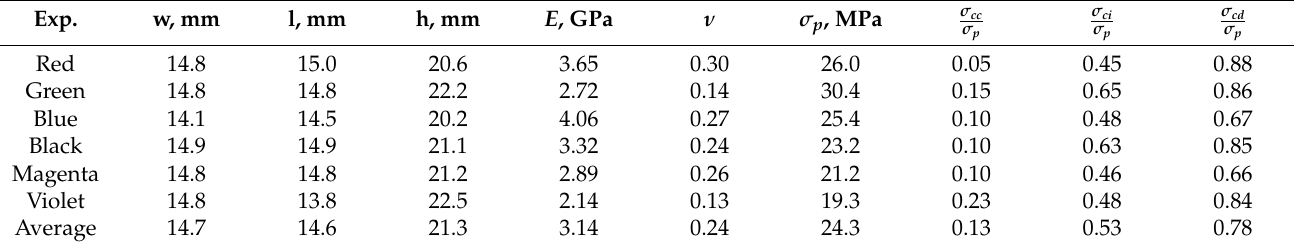
Table 1. Summary of experimental data.